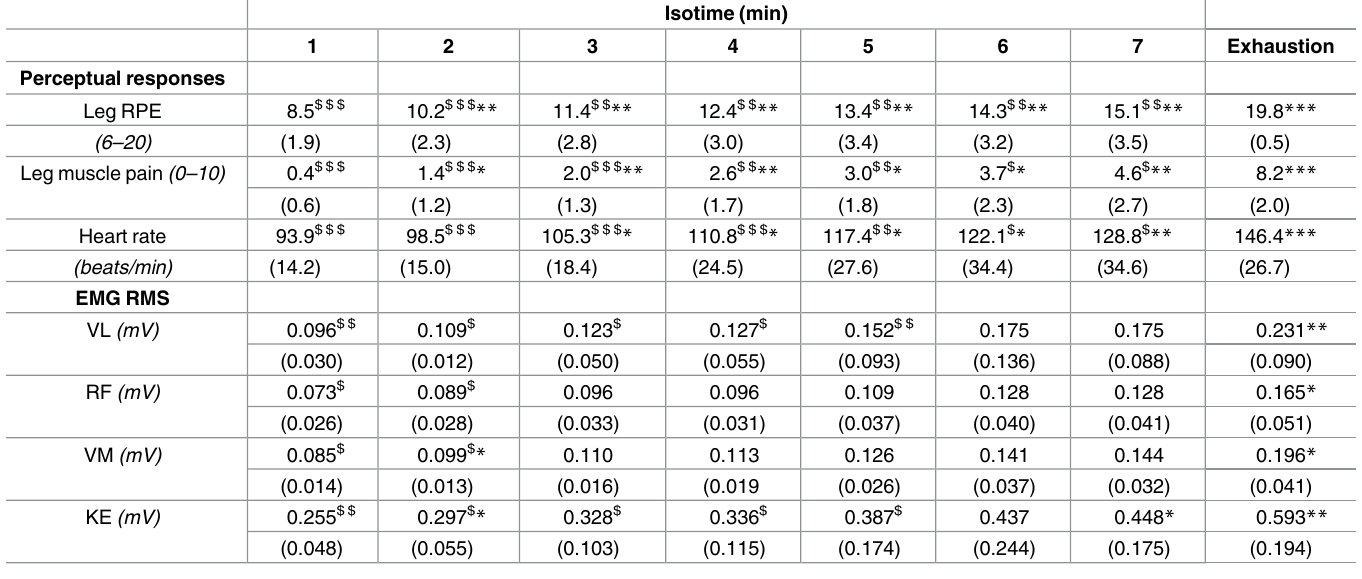
Table 1. Time course of perceptual responses and EMG root mean square (EMG RMS) during the incremental test. EMG RMS was measured for the followingmuscles: Vastus Lateralis (VL), Rectus Femoris (RF), Vastus Medialis (VM) and the overall knee extensors (KE; sum VL, RF and VM). Data are presented as mean (SD). Isotime correspondsto the time completed by all subjects prior to